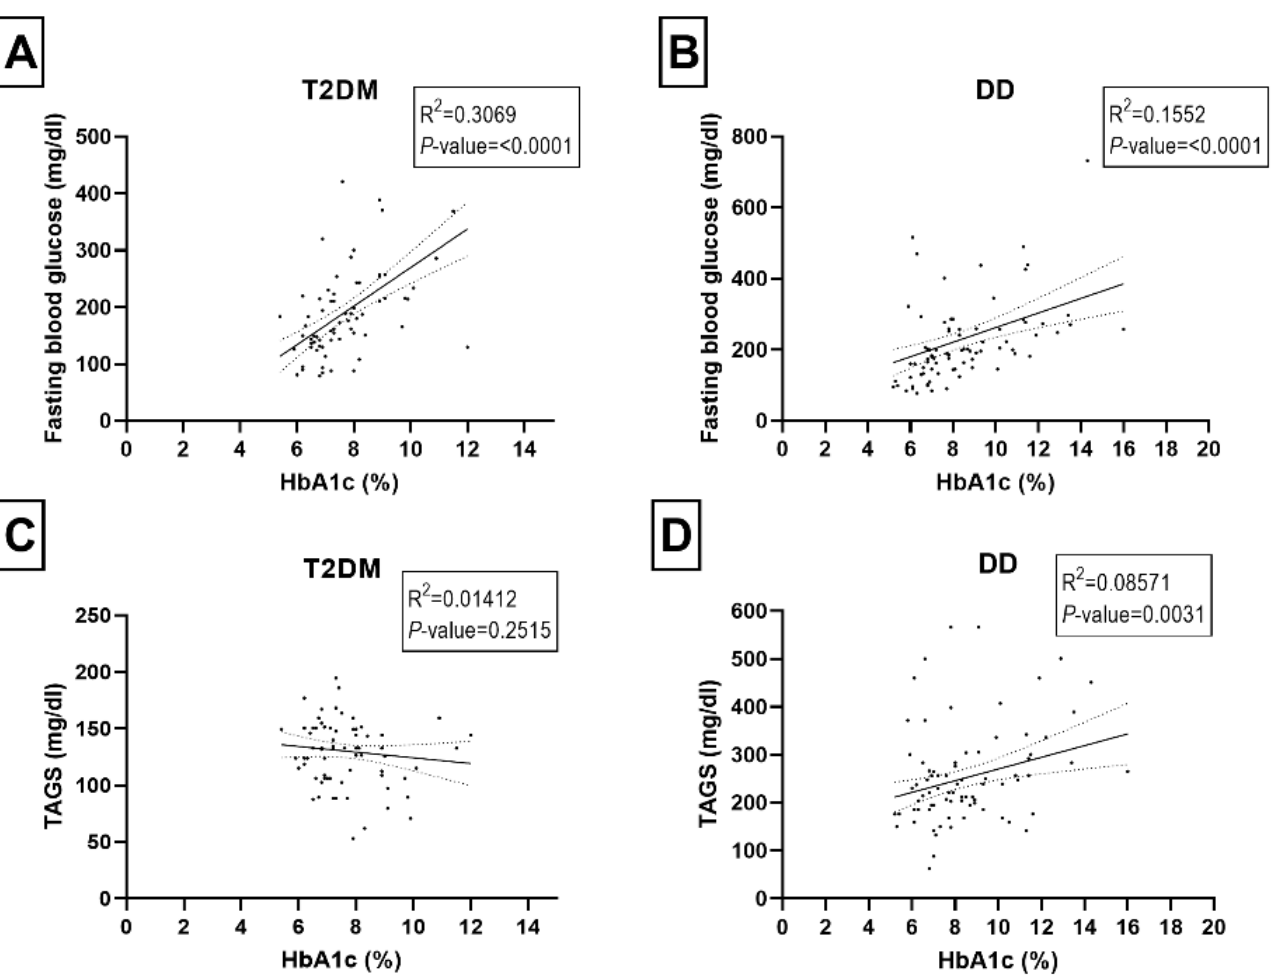
Figure 4. Relationship between HbA1C (%) and biomedical parameters of fasting blood glucose (mg/dl) ( A , B ), serum triglycerides (TAGS mg/dl) ( C , D ) in T2DM and DD group. Each dot of the scattered plot represents the data of individual participants.